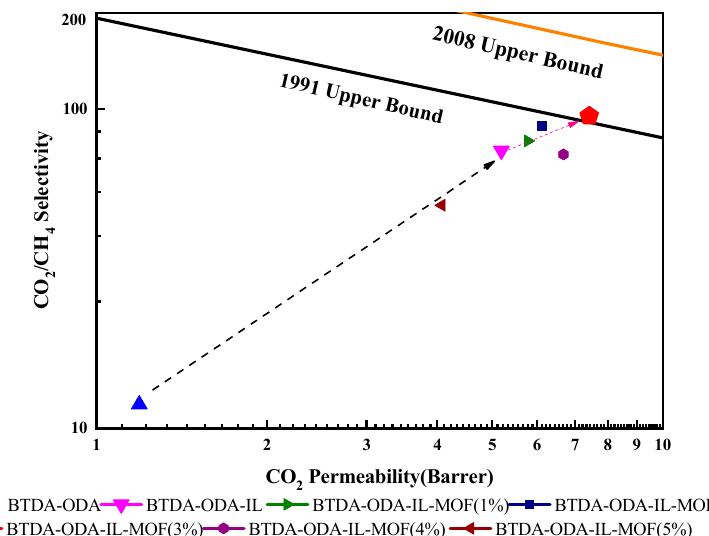
Figure 6. CO 2 /CH 4 separation performance of MMMs and comparison with 1991 Robeson upper bound and 2008 Robeson upper bound.